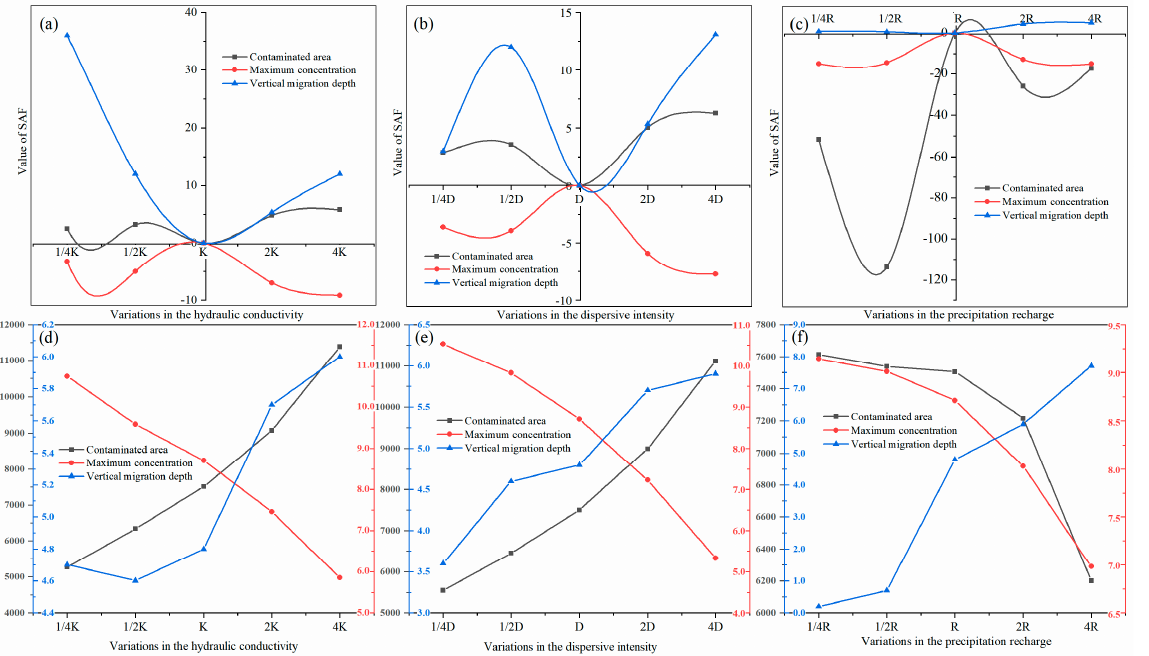
Figure 9. ( a ) Sensitivity analysis of the hydraulic conductivity, ( b ) dispersive intensity, and ( c ) precipitation recharge in the transport model, and the values of the contaminated area, maximum concentration, and vertical migration depth when ( d ) the hydraulic conductivity, ( e ) dispersive intensity, and ( f ) precipitation recharge are changed.